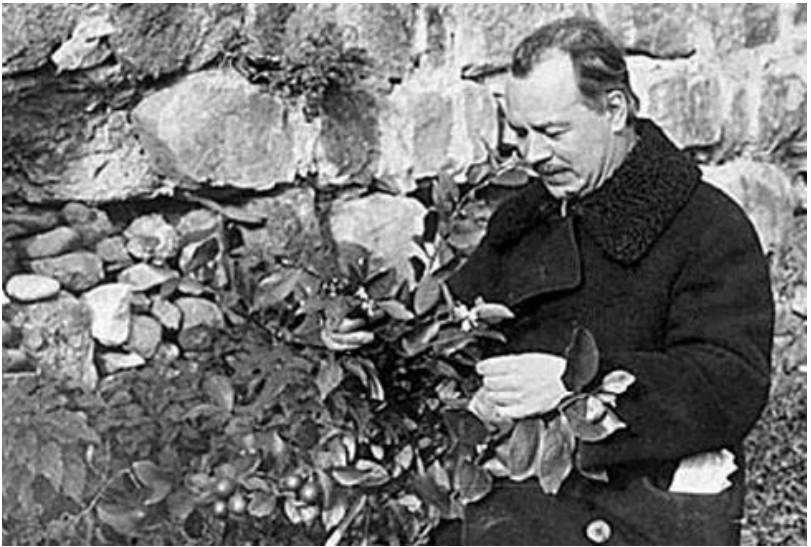
Figure 1. N.I. Vavilov inspecting citrus trees at Maykop, Russia, SFSR (a subdivision of the USSR) in 1935 (Novosti Press Agency).